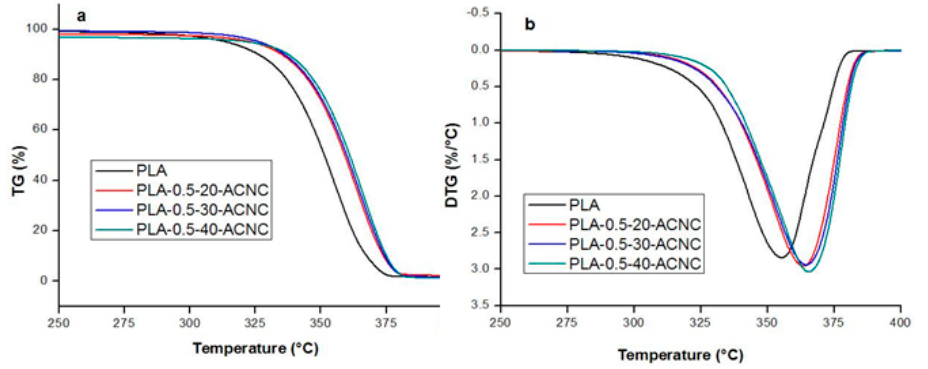
Figure 8. Thermograms of the PLA composite films: ( a ) thermogravimetric analysis curves, ( b ) derivative thermogravimetric curves.